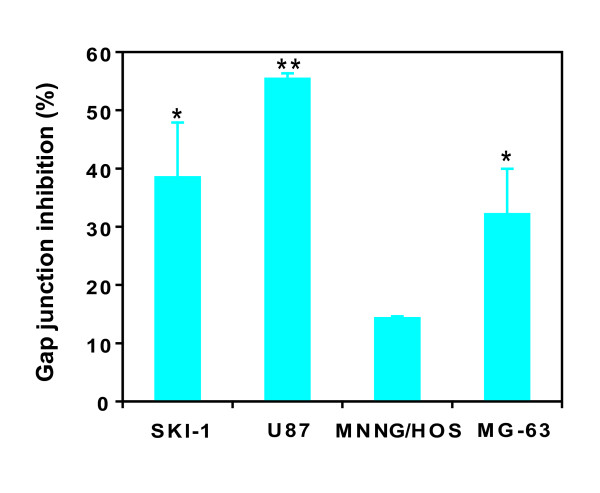
Inhibiton of dye transfer by gemcitabine. The transfer of calcein between cells was evaluated after a 24-hour treatment with 3 μM gemcitabine. Data are the means ± S.D. of three independent experiments. Statistical significance for the inhibition of gap junction was evaluated by a Student t-test (*, p < 0.05; **, p < 0.01).